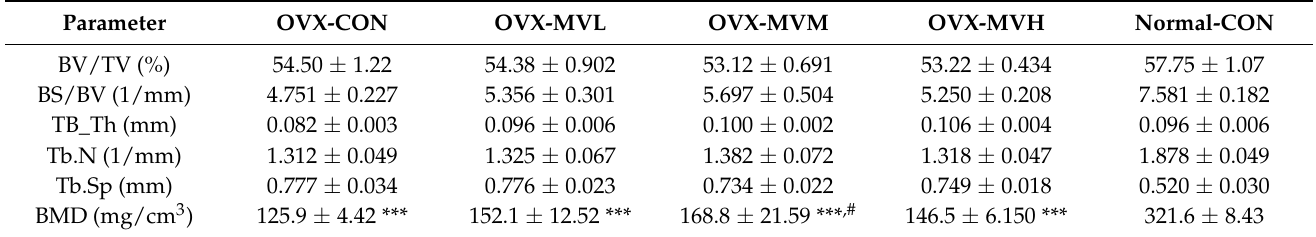
Table 3. Bone mineral density (BMD) of the femur by